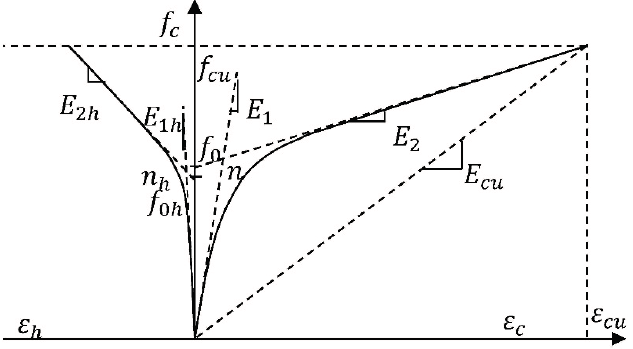
Figure 15. Proposed stress–strain model for GFRP–SR confined concrete in